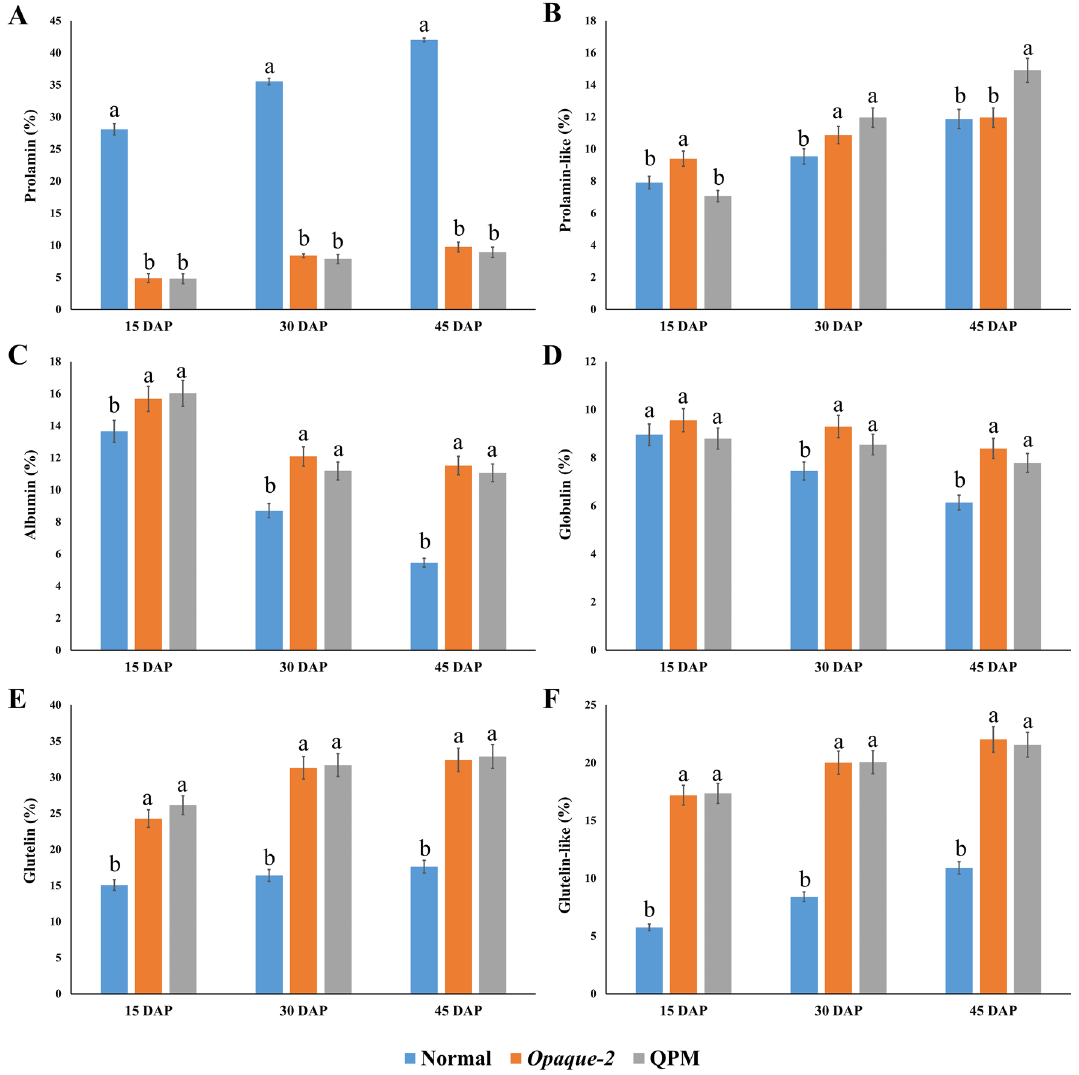
Figure 2. Comparison of protein fractions including zein ( A , B ) and non-zein ( C , D , E , F ) between normal, opaque-2 and QPM lines at different stages of kernel development. Error bars denote ± SD of three replicates. The small alphabets on top of the bar represent the significance level, as per critical difference. Identical alphabet represents non-significant variation at P < Comparison of Zein content in Normal, opaque‑2 , QPM lines in developing kernel. Protein fractions are broadly classified into zein (nutritionally poor) and non-zein (nutritionally rich). The major endosperm storage protein, the prolamin and prolamin-like fractions, are collectively referred to as zeins. These proteins contain a high concentration of amino acids such as glutamine, proline, leucine, and alanine, but are deficient in essential amino acids and therefore they have relatively poor nutritional quality 9 . Our data clearly shows that prolamin fraction was maximally retained in normal as compared to opaque-2 maize at each stage of kernel development (Fig. 2A) with fold differences of 5.74 at 15 DAP, 4.24 at 30 DAP, and 4.32 at 45 DAP. A simi- lar trend of differential prolamin accumulation was observed between normal and QPM lines, with normal lines retaining more prolamin with fold difference of 5.84 at 15 DAP, 4.51 at 30 DAP, and 4.71 at 45 DAP. Although zeins (prolamins and prolamine-like) are nutritionally poor but they significantly contributes towards kernel hardness as reported by Guo et al. (2013) who showed a direct correlation between overall zein content and kernel vitreousness, demonstrating that normal maize with vitreous kernel texture retained more zein content as compared to opaque-2 mutants 27 . Next, it was observed that opaque-2 and QPM had equal amounts of prolamin at initial stages (i.e. at 15 DAP), but when the kernel matured, opaque-2 retained slightly higher prolamin content as compared to QPM, with a fold change of 1.06 at 30 DAP and 1.09 at 45 DAP (Fig. 2A). Overall, the expression profile of prolamin shows that normal maize differs from opaque-2 and QPM at each developmental stage, but the maximum difference was observed at the initial stages of kernel development. Considering the fact that prolamin-like fraction includes sulfur-rich proteins, we next analyzed the prolamin content among opaque-2 and QPM lines. The data depicted in Fig. 2B indicates that there was no uniform trend